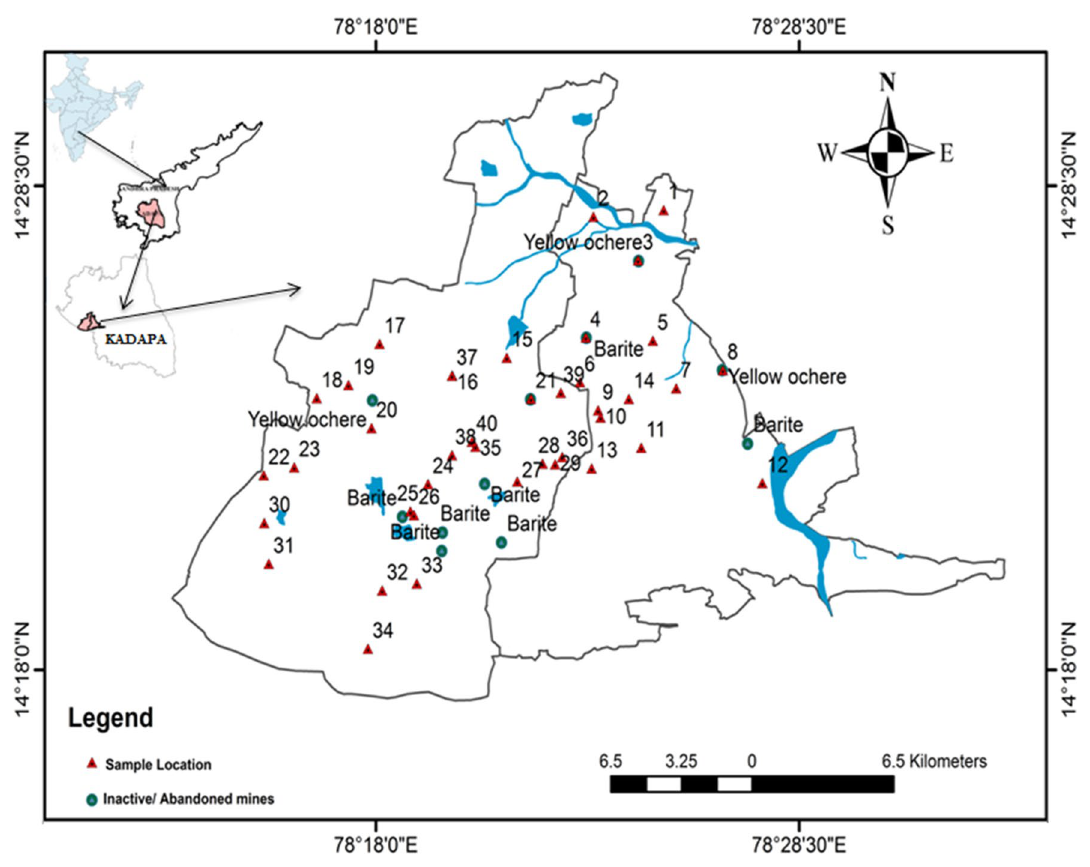
Fig. 1 Location map of study